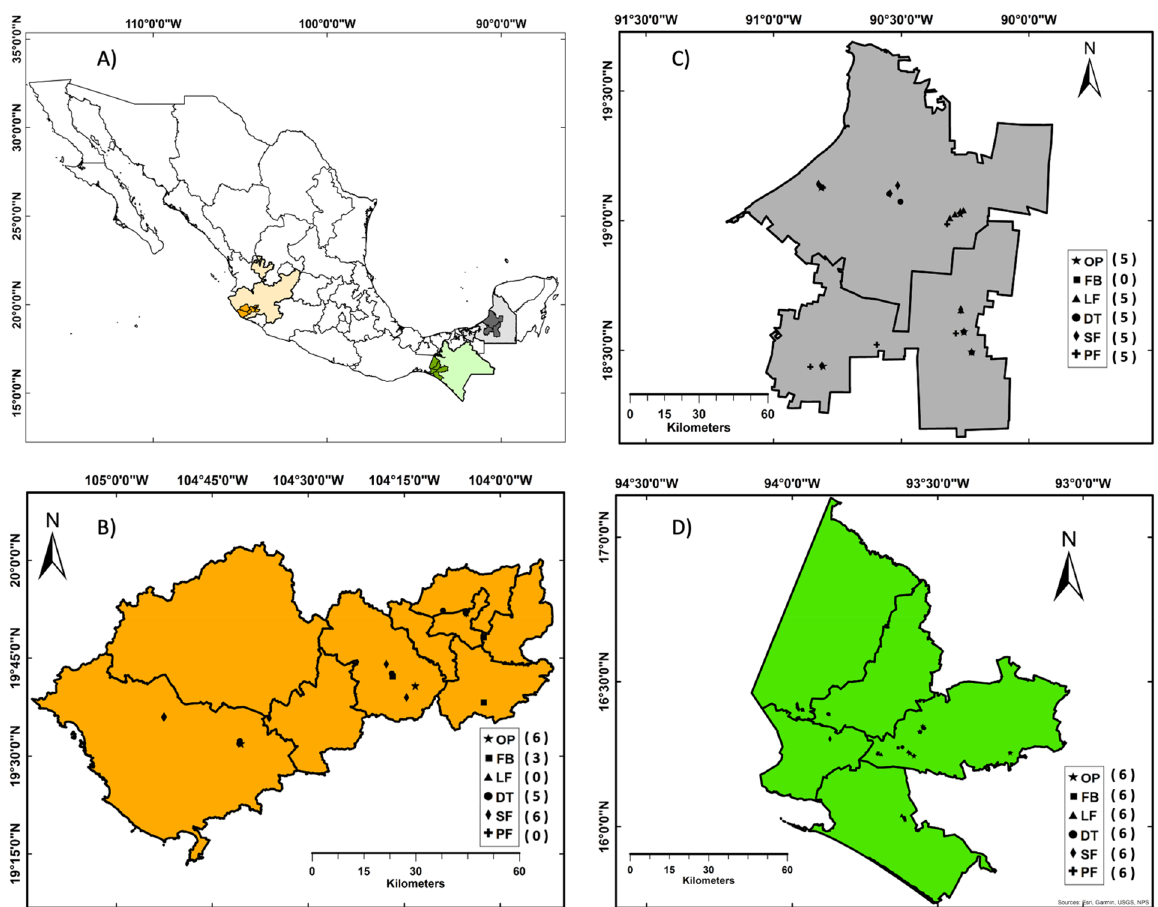
Figure 5. Study area location and distribution of sampling plots across landscapes. ( A ) States (light color) and study areas (darker color) where sampling was conducted. The letters and symbols correspond to the different types of land-uses, OP = Open pasturelands, FB = Fodder banks, LF = Live fences, DT = Pasturelands with dispersed trees, SF = Secondary forests, and PF = Primary forests. ( B – D ) Close-ups of the study sites in Jalisco ( B ), Campeche ( C ), and Chiapas ( D ). The values in the parenthesis show the number of plots sampled (n) for each graduated sticks. Legume trees on FB are usually cut for fodder at about 1 m in height. Hence, the biomass model was developed with the base diameter (30 cm above ground level). An exponential model fitted best to our data with a determination coefficient (R 2 ) of 0.95. The best fit equation is: